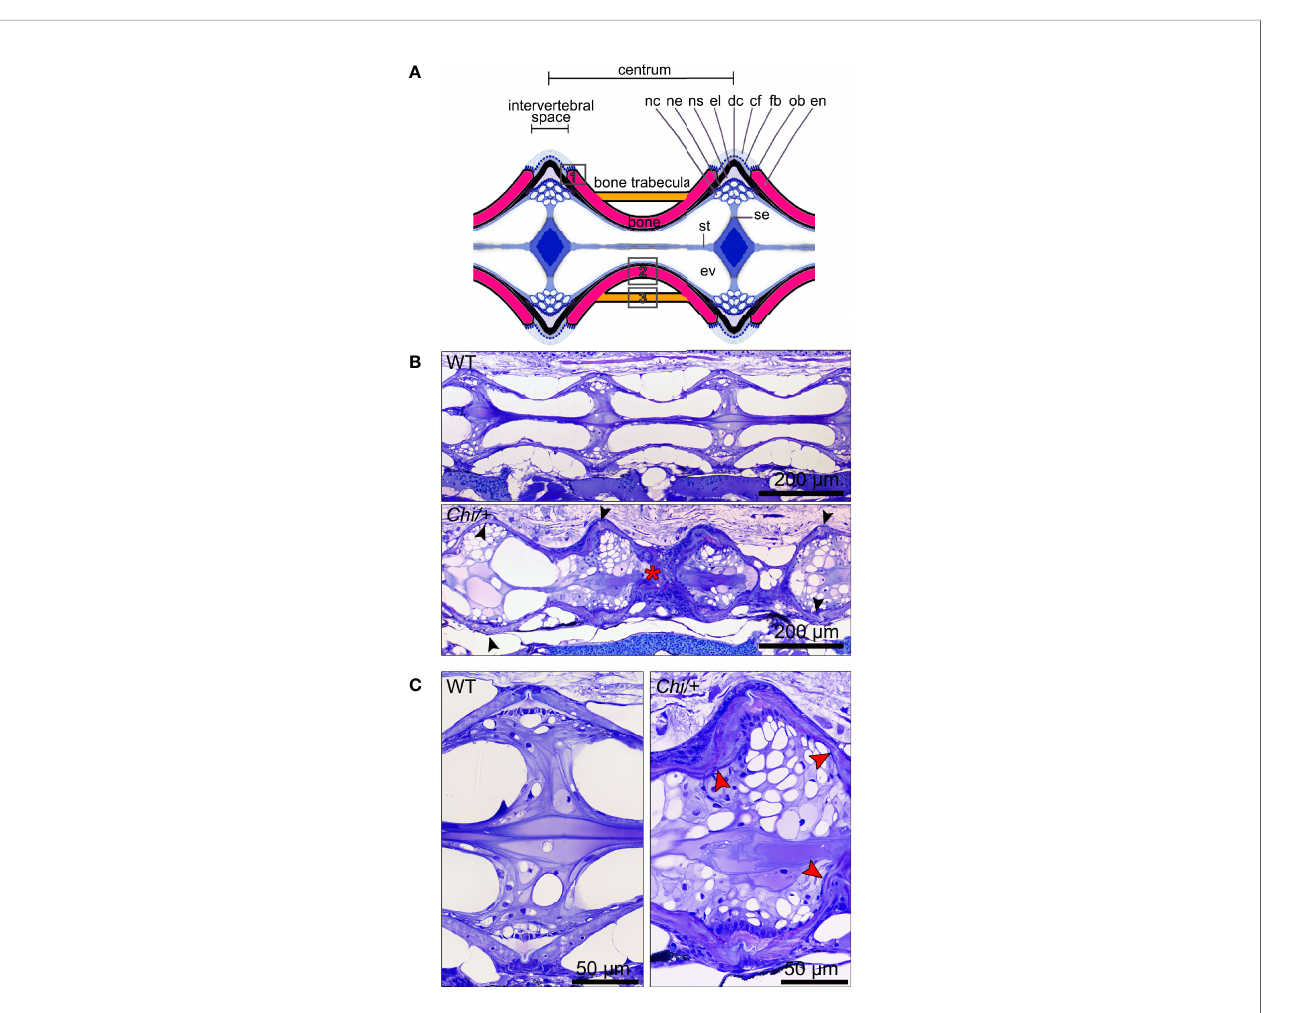
FIGURE 3 | Histology of vertebral column of WT, Chi/+ and Chi /+ LP con fi rms the irregular shape of mutant vertebral bodies. (A) Schematic representation of the medio-sagittal plane of a zebra fi sh vertebral body centrum and two intervertebral spaces. Vertebral centra derive from segmental mineralisation of the notochord sheath and intramembranous bone formation around the notochord. Vertebral body endplates (en) are connected by intervertebral ligaments. Ligaments consist of the enlarged notochord sheath (ns, a collagen type II layer secreted by the cells of the notochord epithelium, ne), its outer elastin layer (el) and dense collagen type I fi bre bundles (dc) produced by fi broblasts (fb) that surround the notochord. The collagen type I fi bre bundles (cf) continue in the bone of the vertebral body endplates (en) as Sharpey fi bres. Osteoblasts (ob) deposit new bone matrix that expands the vertebral body endplates in the bone growth zone. Inside, the notochord is composed of vacuolated notochord cells (nc) and extracellular vacuoles (ev). Condensed notochord cells constitute the notochord septum (se) and the notochord strand (st). Boxes indicate locations where the bone thickness was measured, i.e. endplates (1), central region of vertebrae (2) and trabecular bone (3). (B) Representative three months old WT and mutant sagittal sections of the vertebral column stained with toluidine blue. Compared to WT, Chi/+ mutants (representative also for Chi /+ LP ) have several vertebral centra with deformed endplates that are shifted against each other along the dorsal-ventral axis (black arrowheads). Chi/+ animals also suffer from vertebral body compression fractures (red asterisk), scoliosis, lordosis and kyphosis. Scoliosis can be appreciated from the absence of a straight sagittal midline plane as seen in the WT animal. (C) Higher magni fi cation of vertebral body endplates in WT and Chi/+ (representative also for Chi /+ LP ) animals. Toluidine blue staining shows deformed endplates of adjacent vertebral bodies (red arrowheads) in Chi/+ mutants, yet with unaltered ligaments and unaltered intervertebral space as in